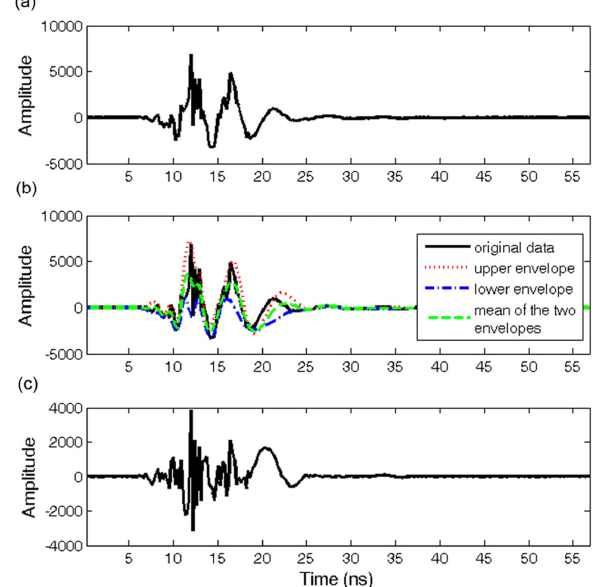
Fig. 1. Process of sifting. (a) The original single trace data g(t) extracted from a typical GPR record acquired in the field. (b) Orig- inal data g(t) with upper and lower envelopes and the mean m 1 of the two envelopes. (c) The first mode, d 1 , which is the difference between the original data and m 1 . This is not an IMF